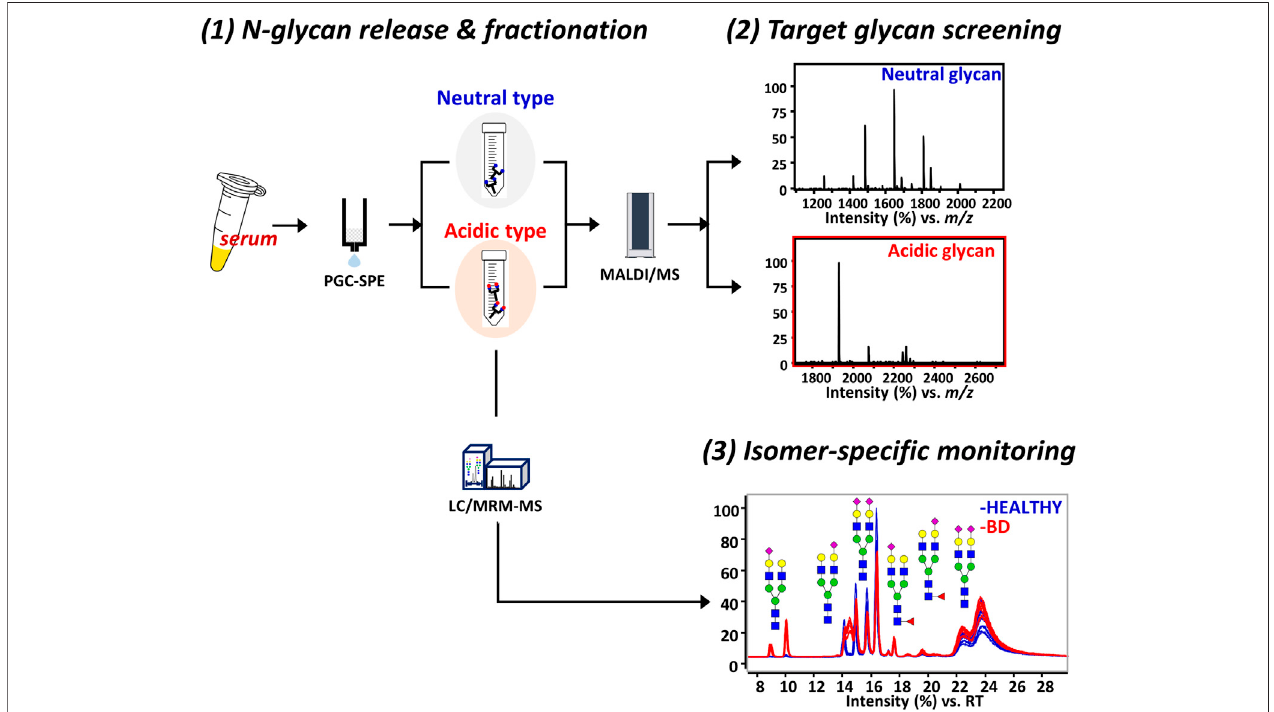
FIGURE 1 | Schematic illustration of the experimental work fl ow for isomer-speci fi c monitoring. The platform consists of three steps including 1) N -glycan fractionation, 2) mass pro fi ling of glycans, and 3) LC/MRM-MS analysis of glycans with BD-speci fi c epitopes. For the glycan cartoons, green circles denote mannose, yellow circles denote galactose, blue squares denote N -acetylglucosamine, red triangles denote fucose, and purple diamonds denote N -acetylneuraminic acid. LC, liquid chromatography; MRM, multiple reaction monitoring; MS, mass spectrometry; BD, Behcet ’ s